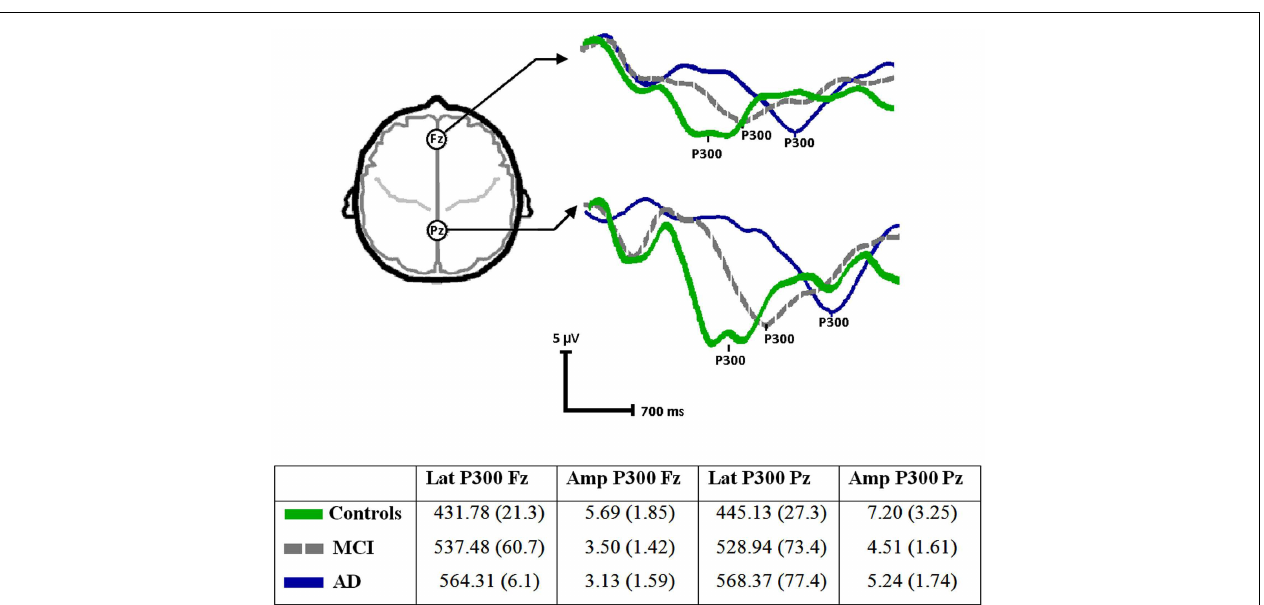
FIGURE 1 | ERPs (P300) waveforms and parameters (mean and SD) from the three groups (Controls, MCI, andAD) recorded at Fz (anterior) and Pz